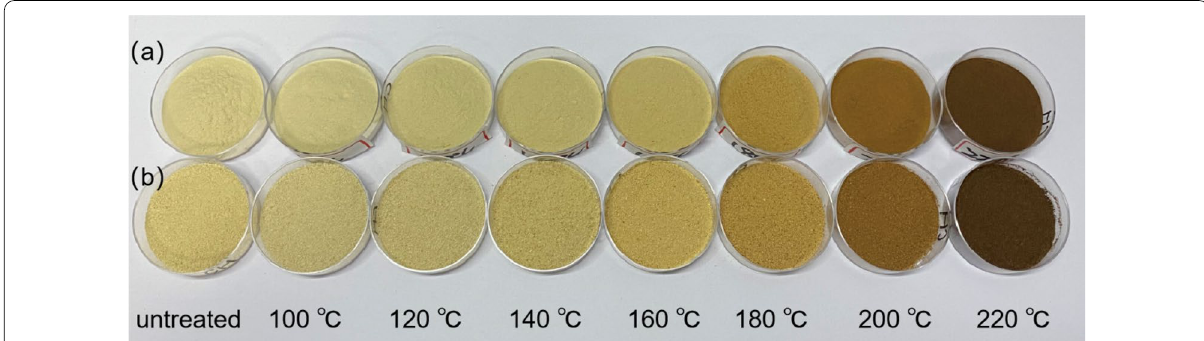
Fig. 2 The color of the heat-treated a fibers and b parenchyma